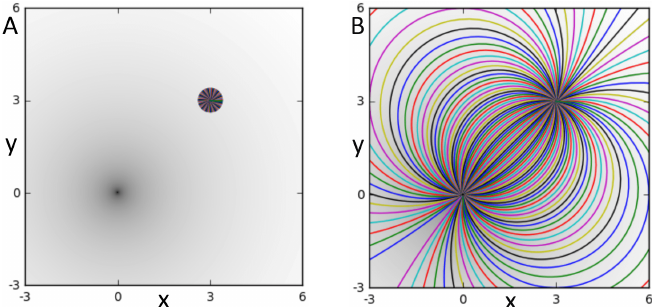
Figure 10: Geodesic trajectories for the isotropic power-law model with α = 2. A: Geodesics released at ( 3,3 ) with various angles. B: Long-term geodesic dynamics, in agreement with Eqs. (56a) and